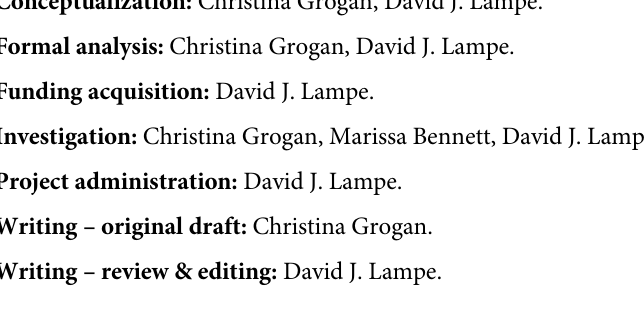
S1 Table. Oligonucleotides and synthetic dsDNA fragments used in this study. Restriction sites are underlined. S1 Raw image. Original uncropped western blot corresponding to Fig 2C in the manu- script, marked in the same manner. The membrane was visualized on an Odyssey FC dual mode imaging system (LI-COR) using the 800 nm infrared fluorescent detection channel for 2 min. Image Studio Software 5.0 (LI-COR) was used for blot visualization. SF2.1,